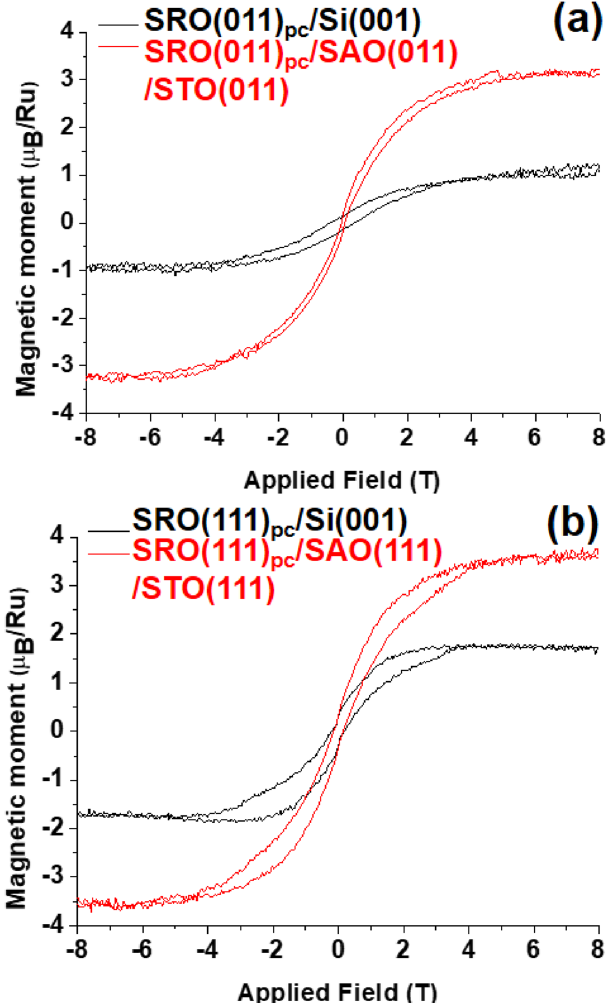
Figure 5. Magnetic hysteresis loops measured with the applied magnetic field perpendicular to the film surface of SRO(011) pc ( a ) and SRO(111) pc ( b ) films at 2 K. The saturated magnetic moment for Ru 4+ was 3.2 μ B /Ru 4+ and 3.5 μ B /Ru 4+ for the SRO(011) pc and SRO(111) pc films, respectively, when they were on SAO/ STO heterostructures, probably because of the presence of the Ru 4+ high-spin state. After the transfer onto Si substrates, SRO(011) pc and SRO(111) pc films had 1.0 μ B /Ru 4+ and 1.7 μ B /Ru 4+ , respectively, as their crystal structure were relaxed to the bulk SRO from epitaxial strain and lattice distortion by SAO/STO